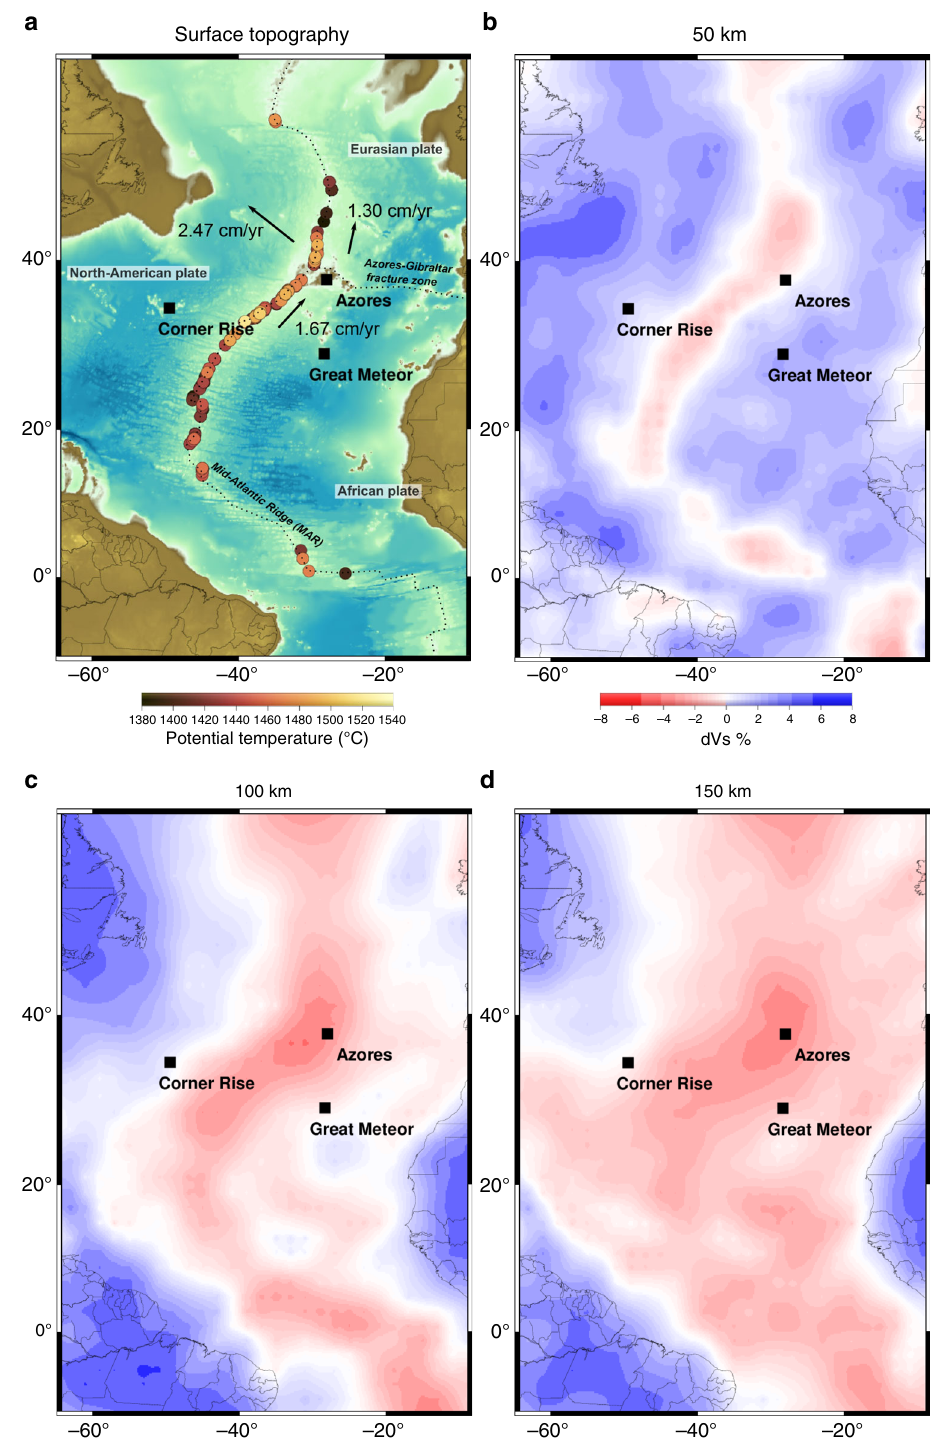
Fig. 1 Geographical setting and seismic tomography of the upper mantle. a Surface topography of the Central Atlantic Ocean and potential temperatures obtained from the PRIMELT method along the MAR (see Fig. 2). The direction and magnitude (in cm/yr) of plate velocities according to their absolute motions during the last 10 Ma in a moving hotspot reference frame 42 in the vicinity of the Azores are denoted by the black arrows and numbers. b – d Upper mantle shear wave tomography slices from the global upper mantle and transition zone model 3D2017_09SV